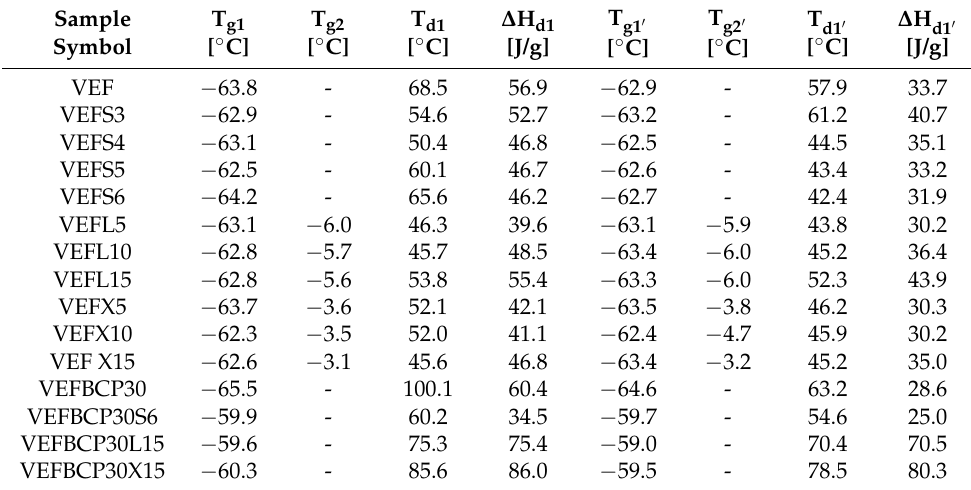
Table 6. Results of DSC thermogram analysis of the tested